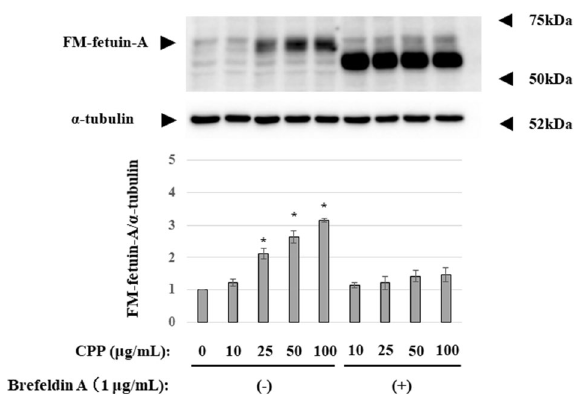
Figure 5. Effect of brefeldin A on secondary CPP-induced FM-fetuin-A. HepG2 cells were pre-treated for 30 min with or without 1 mg/mL brefeldin A and subsequently incubated in the absence or presence of the indicated concentrations of secondary CPP for 24 h. Immunoblots of cell lysates were probed with fetuin-A (upper panel) and α-tubulin (lower panel) antibodies. FM-fetuin-A levels were quantified using α-tubulin as an endogenous reference, with the fetuin-A level in the absence of CPP without brefeldin A defined as 100% (control). Data are shown as mean ± SD from at least three independent experiments. *P < 0.05 vs. control. Full- length blots/gels are presented in Supplementary Fig. X5